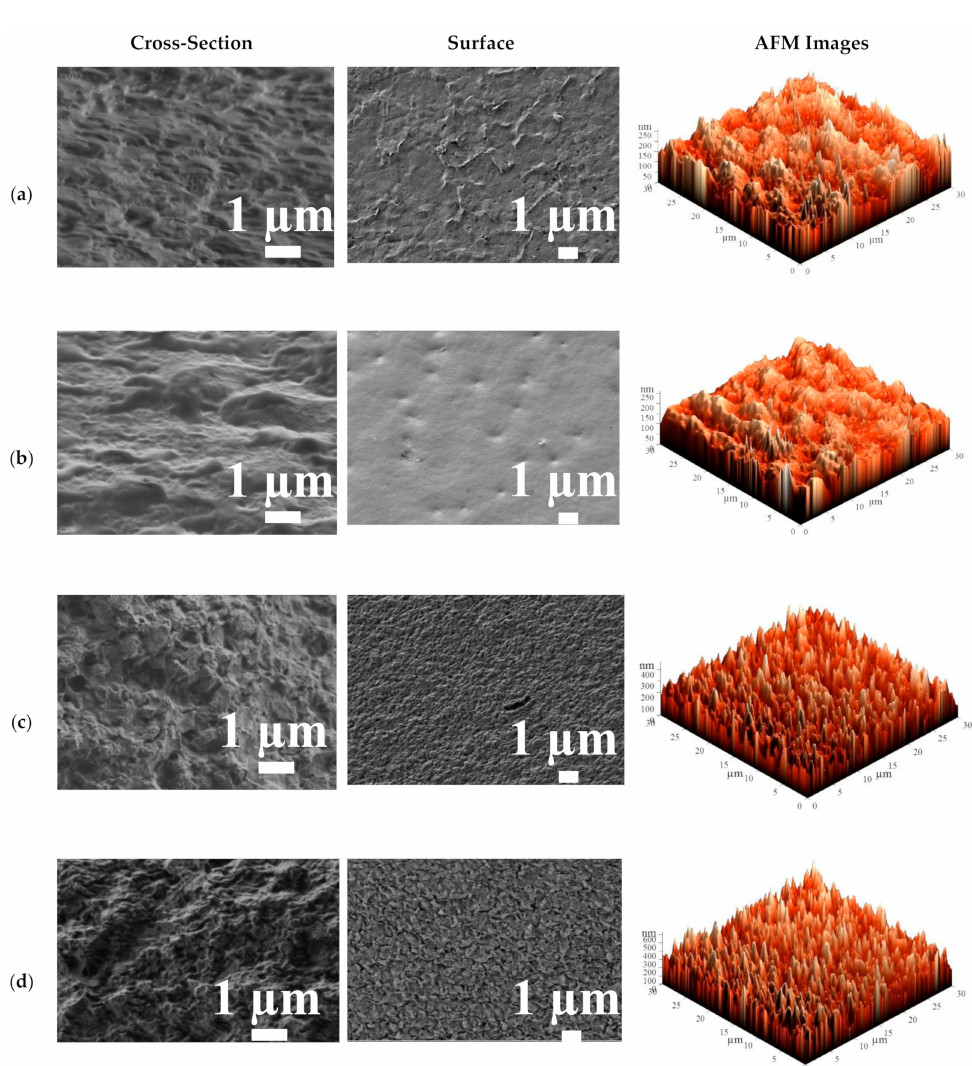
Figure 10. The cross-sectional and surface SEM micrographs and AFM images of the cross-linked HEC/SA membranes: ( a ) HEC/SA CA , ( b ) HEC/SA PA , ( c ) HEC/SA CaCl2 , and ( d ) HEC/SA-5 CaCl2